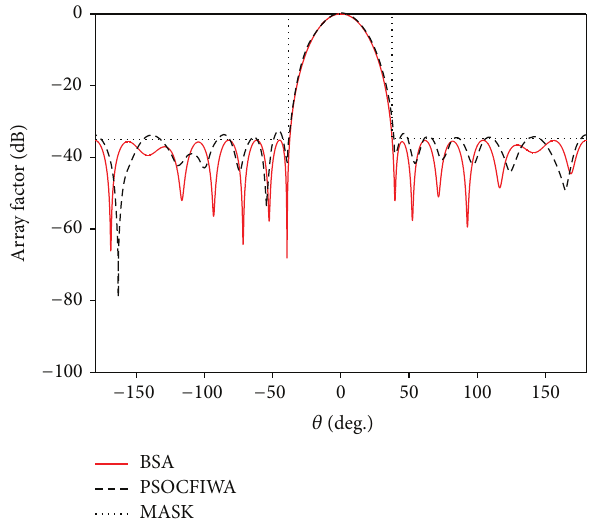
Figure 14: The radiation patterns obtained by BSA and PSOCFIWA [1] for CCAA with central element .